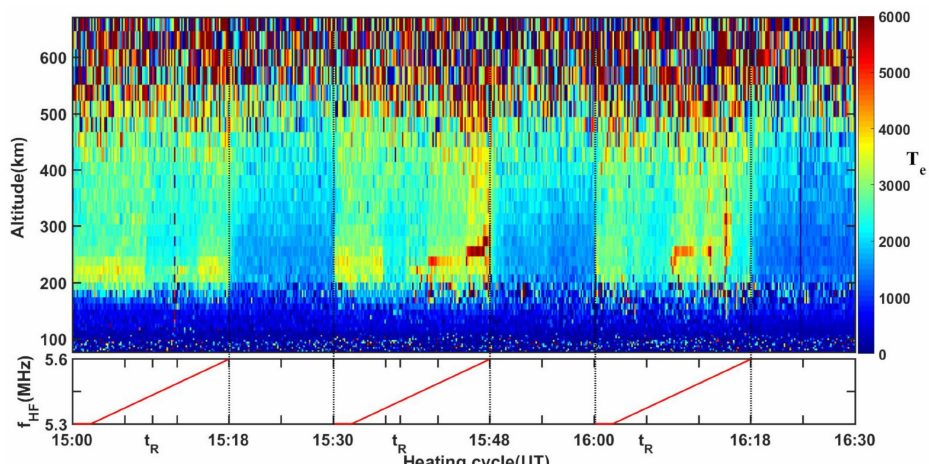
Figure 4. Electron temperature varies with time (t) and altitude (h) when heating.